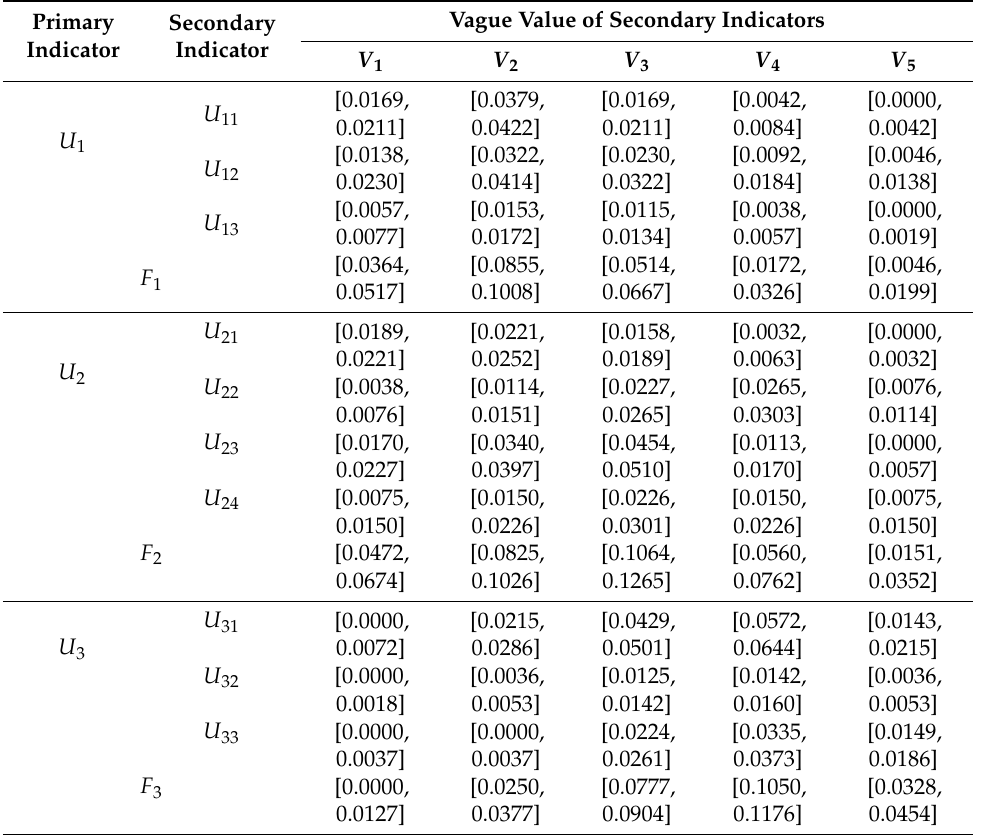
Table 5. Comprehensive evaluation result of vague value (Project